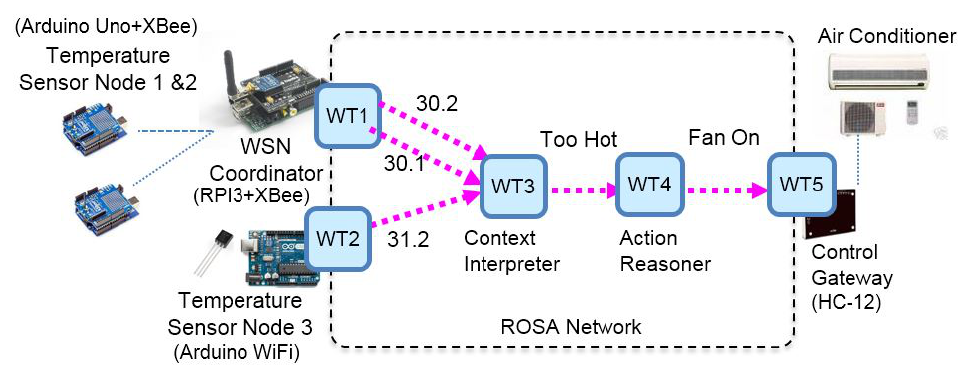
Figure 7. The prototyped ROSA application scenario; The dotted lines indicate